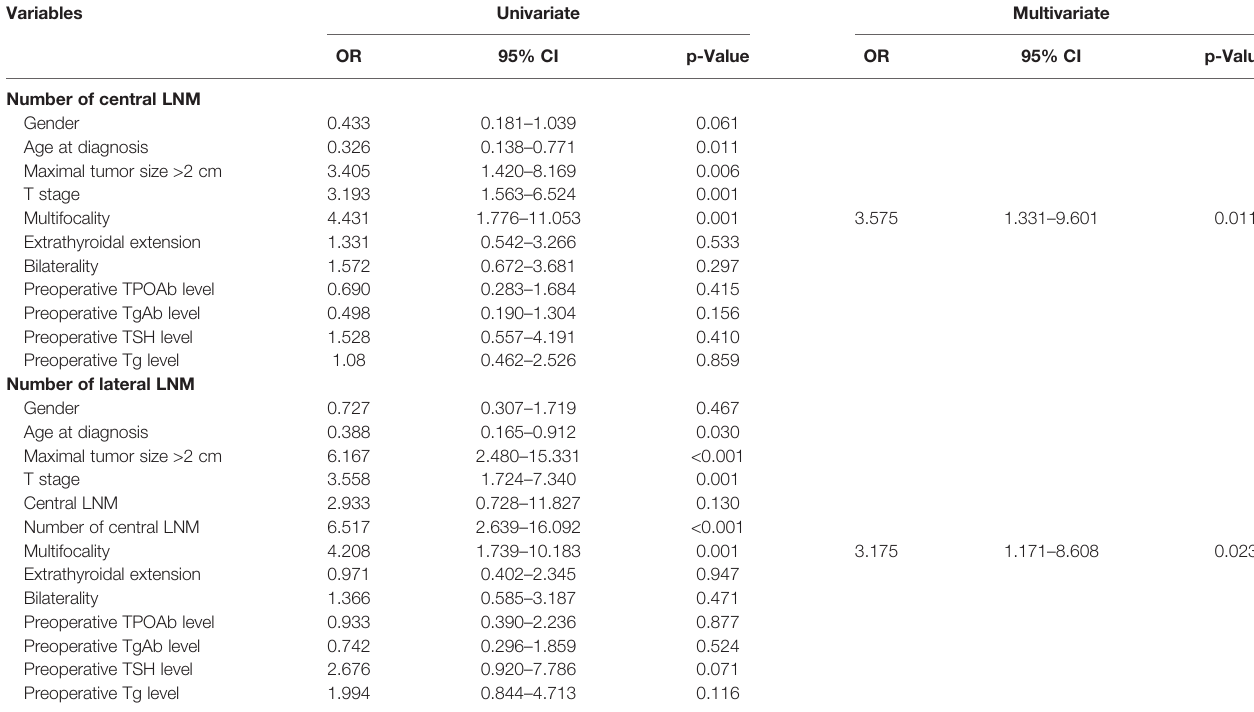
TABLE 4 | Factors related to the number of positive cervical lymph node metastasis ( ≤ 5 vs. >5).